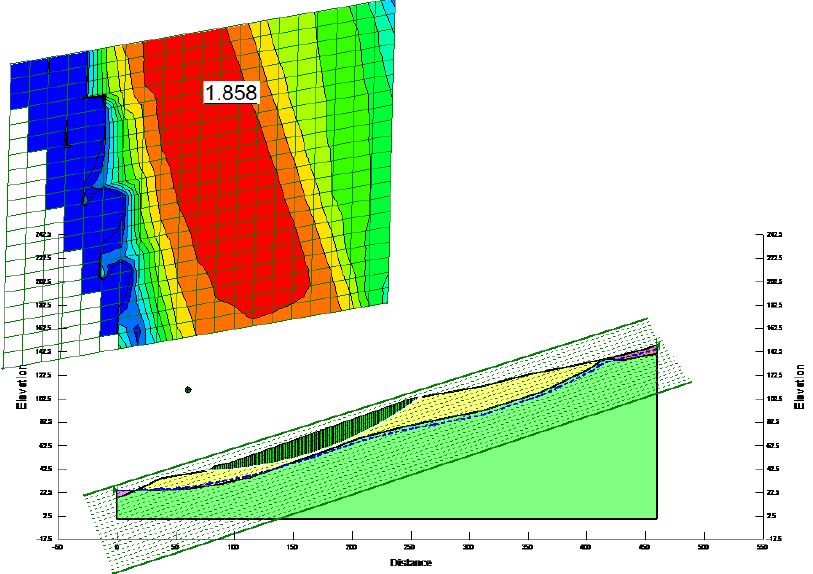
Fig. 9. Minimum safety factor of slope stability using Grid and Radius